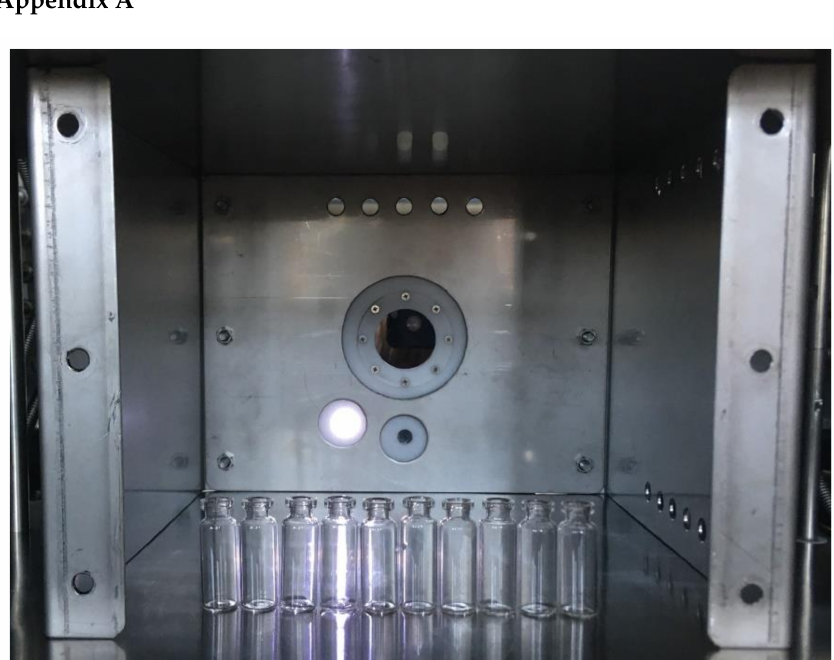
Figure A1. Picture of the box used with the IR sensor behind it and 10 vials placed ~25 cm from the sensor, as set for the experiments. The front wall of the box was removed for the picture.